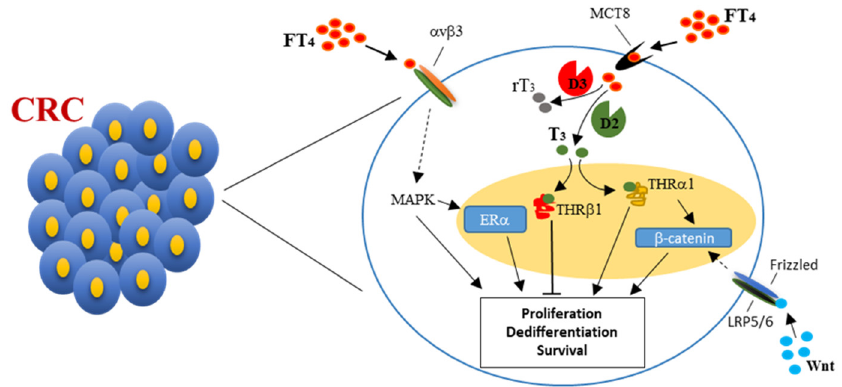
Figure 1. Schematic representation of thyroid hormones action on colorectal cancer (CRC) cells . FT4, free-thyroxine; α v β 3, integrin receptor; MCT8, monocarboxylate transporter 8; D2, type 2 deiodinase; D3, type 3 deiodinase; MAPK, mitogen-activated protein kinases; ER, estrogen receptor; THR, thyroid hormone receptor. See text for explanation.